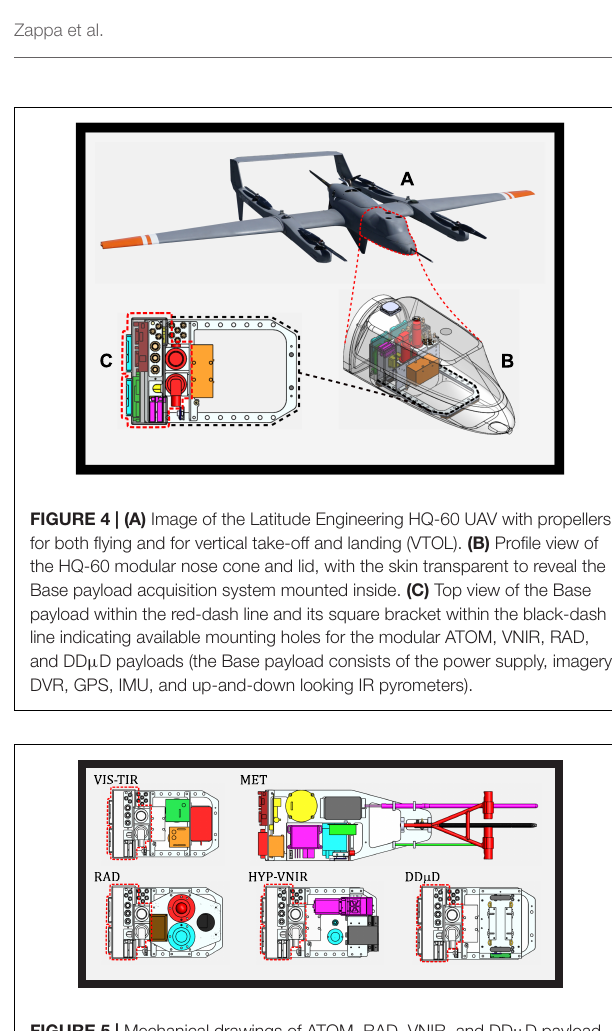
FIGURE 5 | Mechanical drawings of ATOM, RAD, VNIR, and DD µ D payload sensors. The Base payload acquisition system (also shown in Figure 4 ) are indicated by the red dashed line. The MET payload is completely different from the other payloads, which primarily has a completely different acquisition system, with nose-exiting probes and stingers to measure fast-response 3D wind, temperature, and humidity, and an industry-leading GPS and fiber-optic gyro IMU to correct for in-flight UAV motion to the highest possible